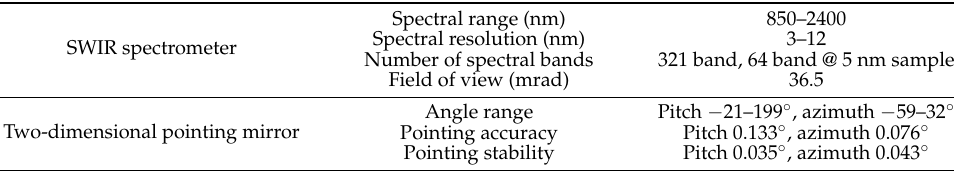
Table 1. Main technical parameters of MarSCoDe